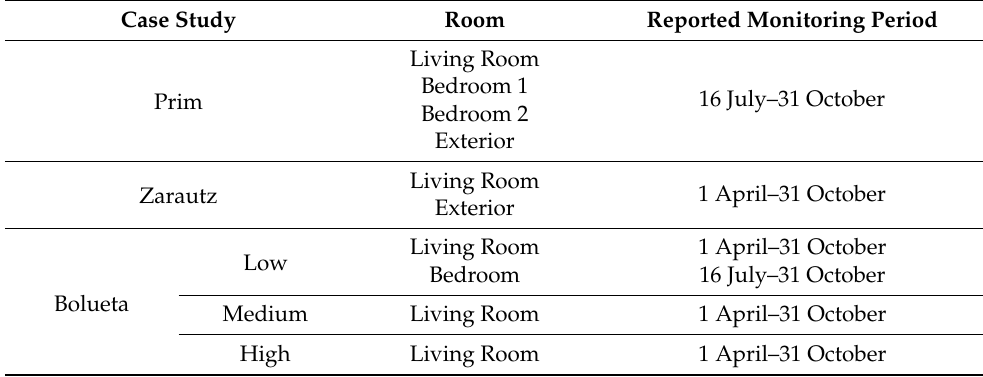
Table 4. Summary of monitoring periods in each of the 5 apartments.